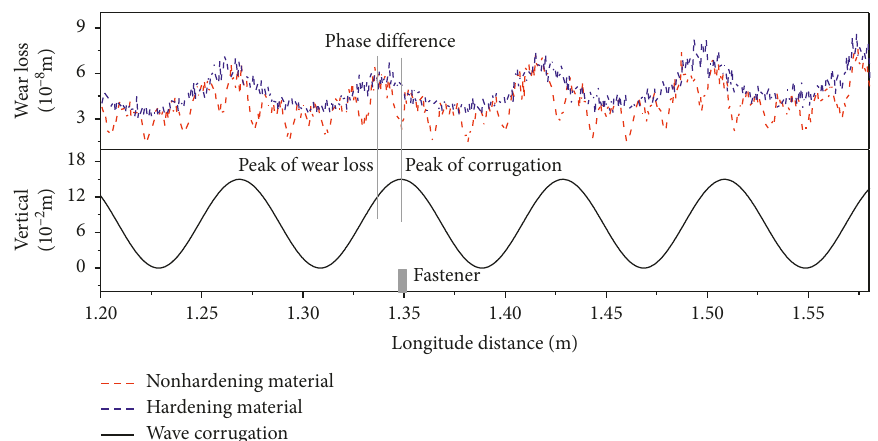
Figure 20: Wear loss along longitudinal direction of rail with hardening and nonhardening